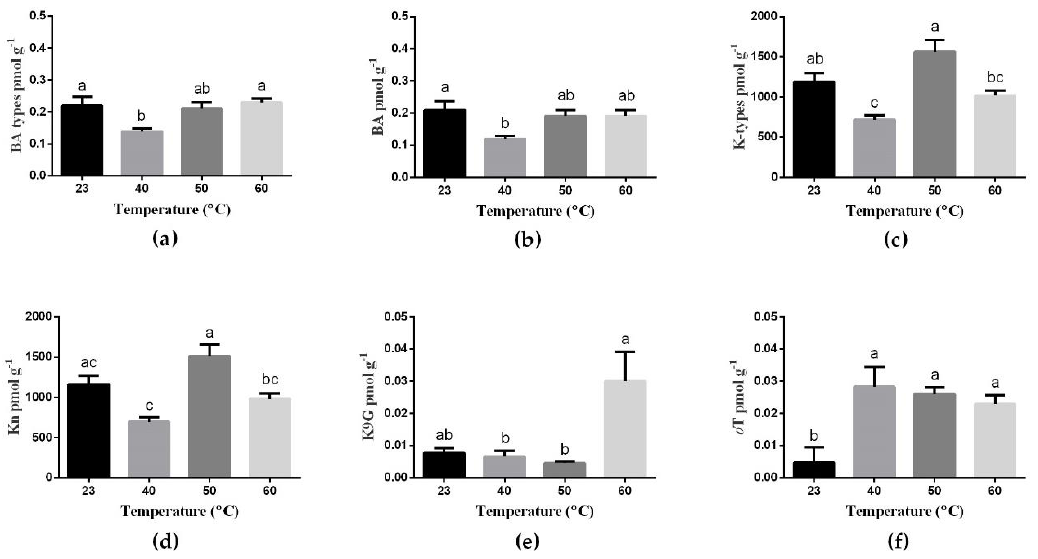
Figure 9. Effect of different temperatures (23 °C, 9 weeks; 40 °C, 4 h; 50 °C, 30 min; 60 °C, 5 min) at Figure 9. E ff ect of di ff erent temperatures (23 ◦ C, 9 weeks; 40 ◦ C, 4 h; 50 ◦ C, 30 min; 60 ◦ C, 5 min) at endogenous concentration (pmol g −1 FW± SE) of ( a ) total BA types; ( b ) BA; ( c ) total K types; ( d ) Kn; endogenous concentration (pmol g − 1 FW ± SE) of ( a ) total BA types; ( b ) BA; ( c ) total K types; ( d ) Kn; ( e ) K9G; ( f ) o T. ( e ) K9G; ( f ) o